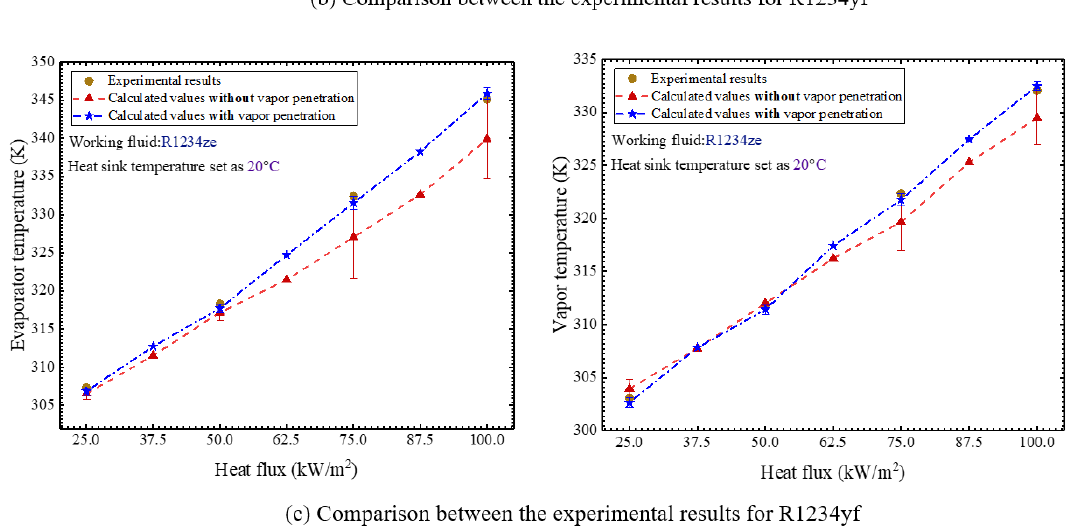
Figure 10. The experimental results of vapor and evaporator variations with heat flux and comparison with results from two numerical models for different working fluids.